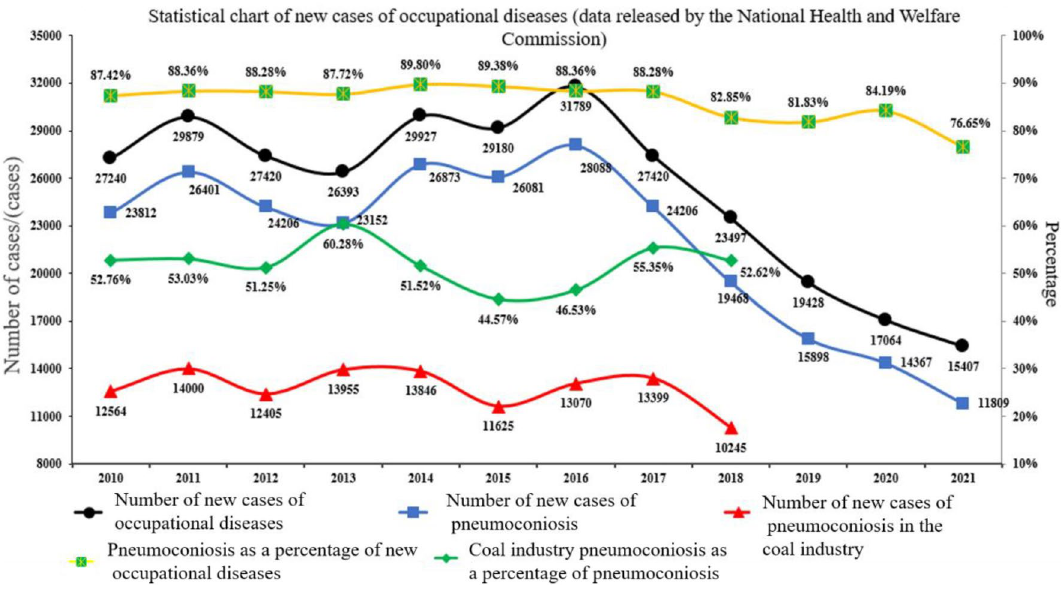
Figure 1. Statistics of occupational disease